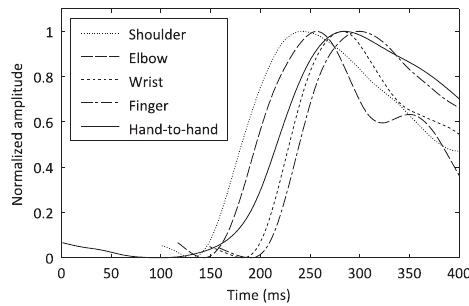
Fig.5: Hand-to-hand IPG and local IPG at the shoulder, elbow, wrist, and the index finger.